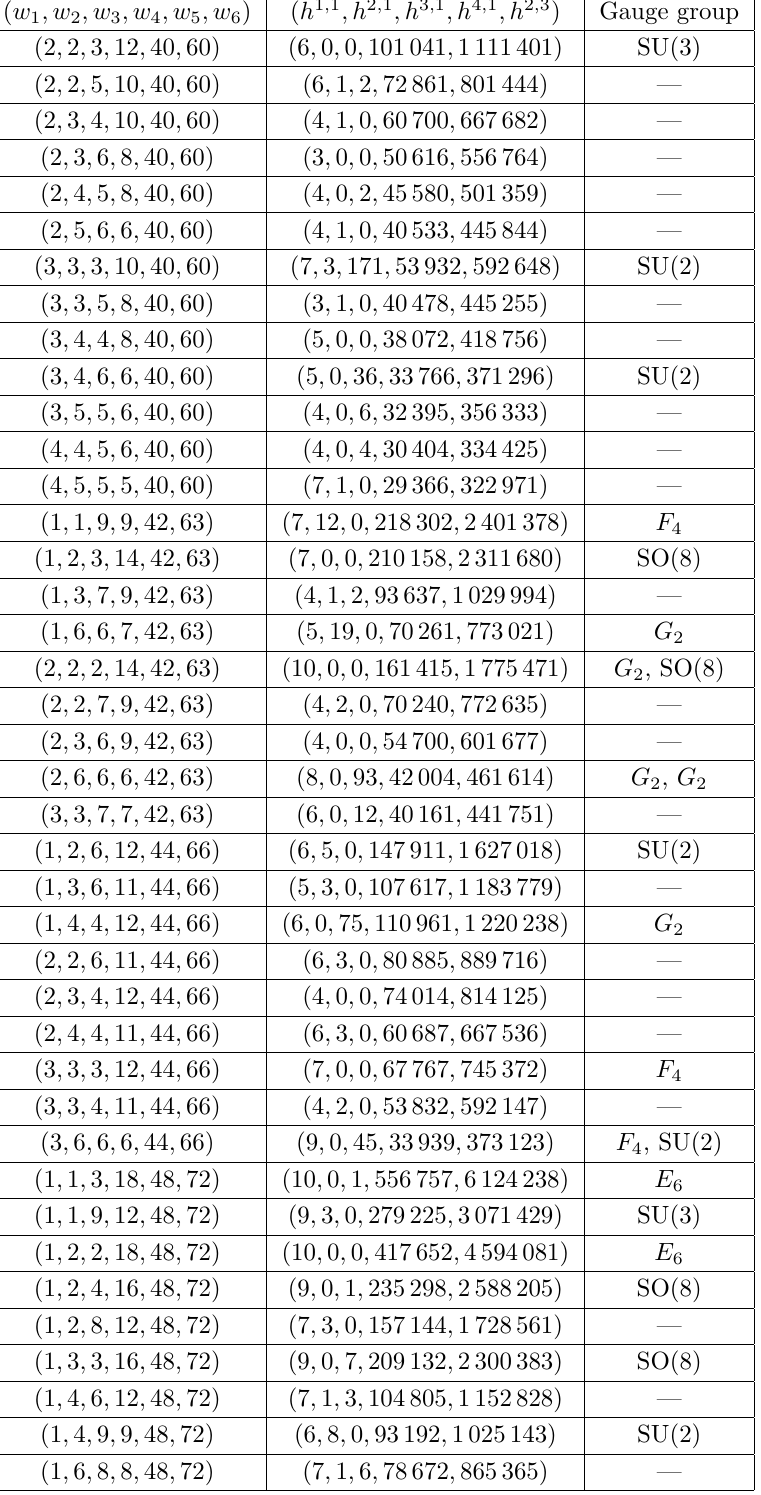
Table 11 . A list of elliptic CY5 hypersurfaces in weighted projective spaces P 1 ,w 1 ,w 2 ,w 3 ,w 4 ,w 5 ,w 6